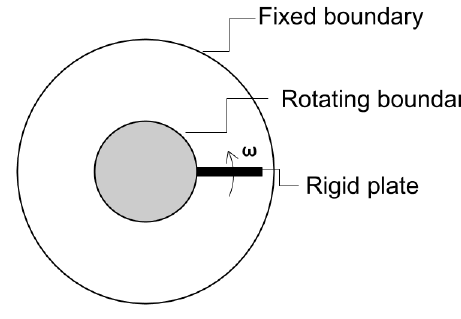
Figure 2. Flow due to oscillation of inner cylinder with a rigid plate attached to it.